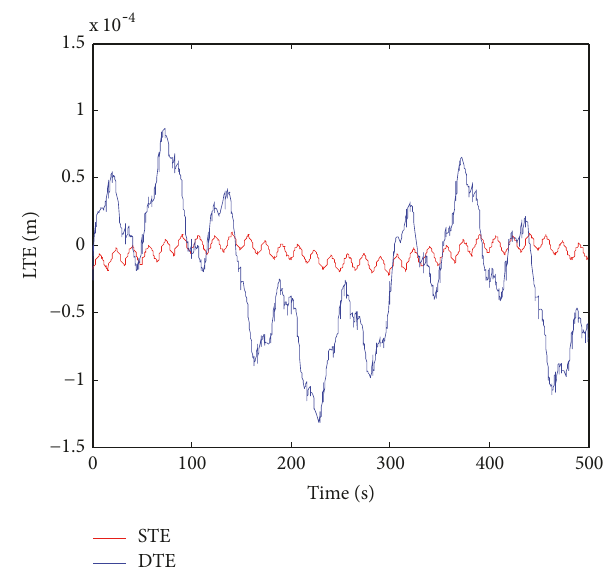
Figure 8: Comparison of DTE and